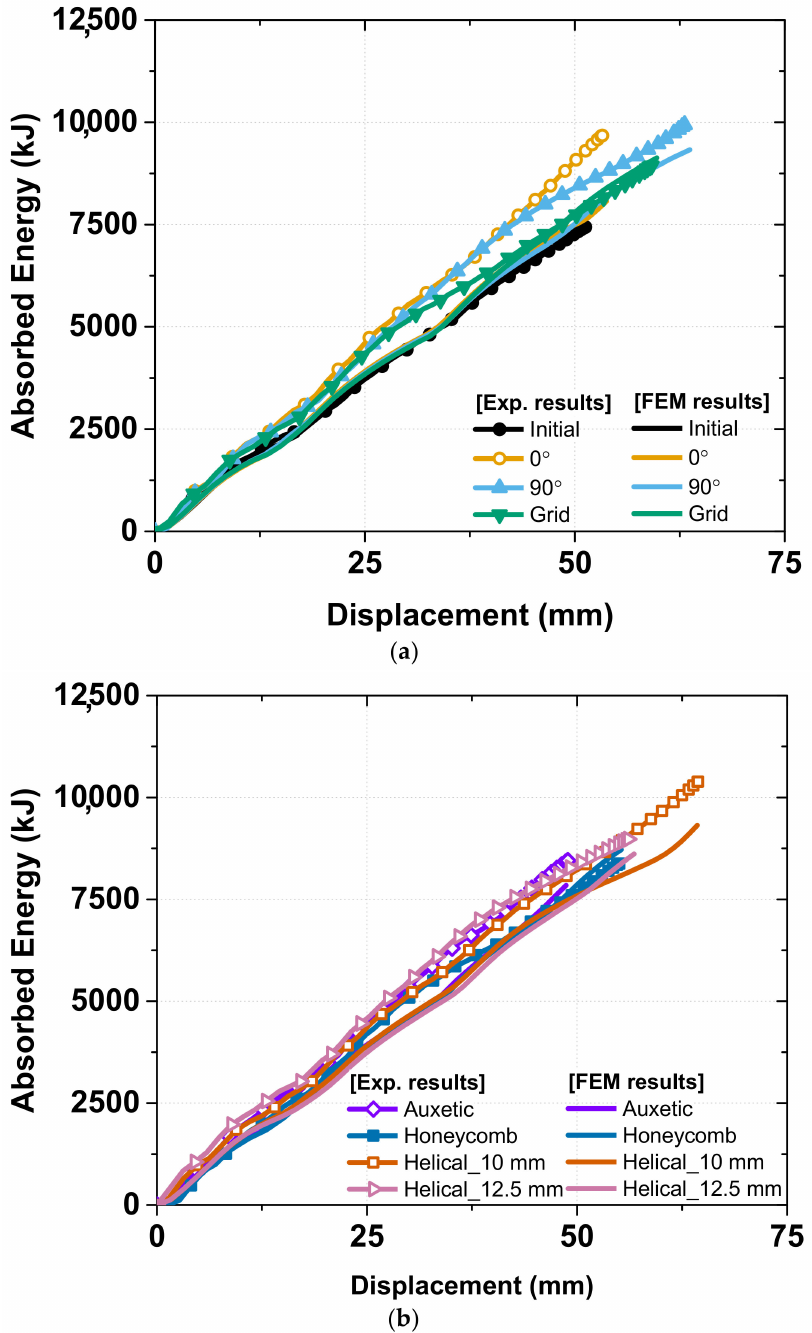
Figure 17. Comparing Total absorbed energy between FEM analysis and Experiment: ( a ) Group 1: initial, 0 ◦ , 90 ◦ and grid; ( b ) Group 2: auxetic, honeycomb, helical with pitch of 10 mm and helical with pitch of 12.5